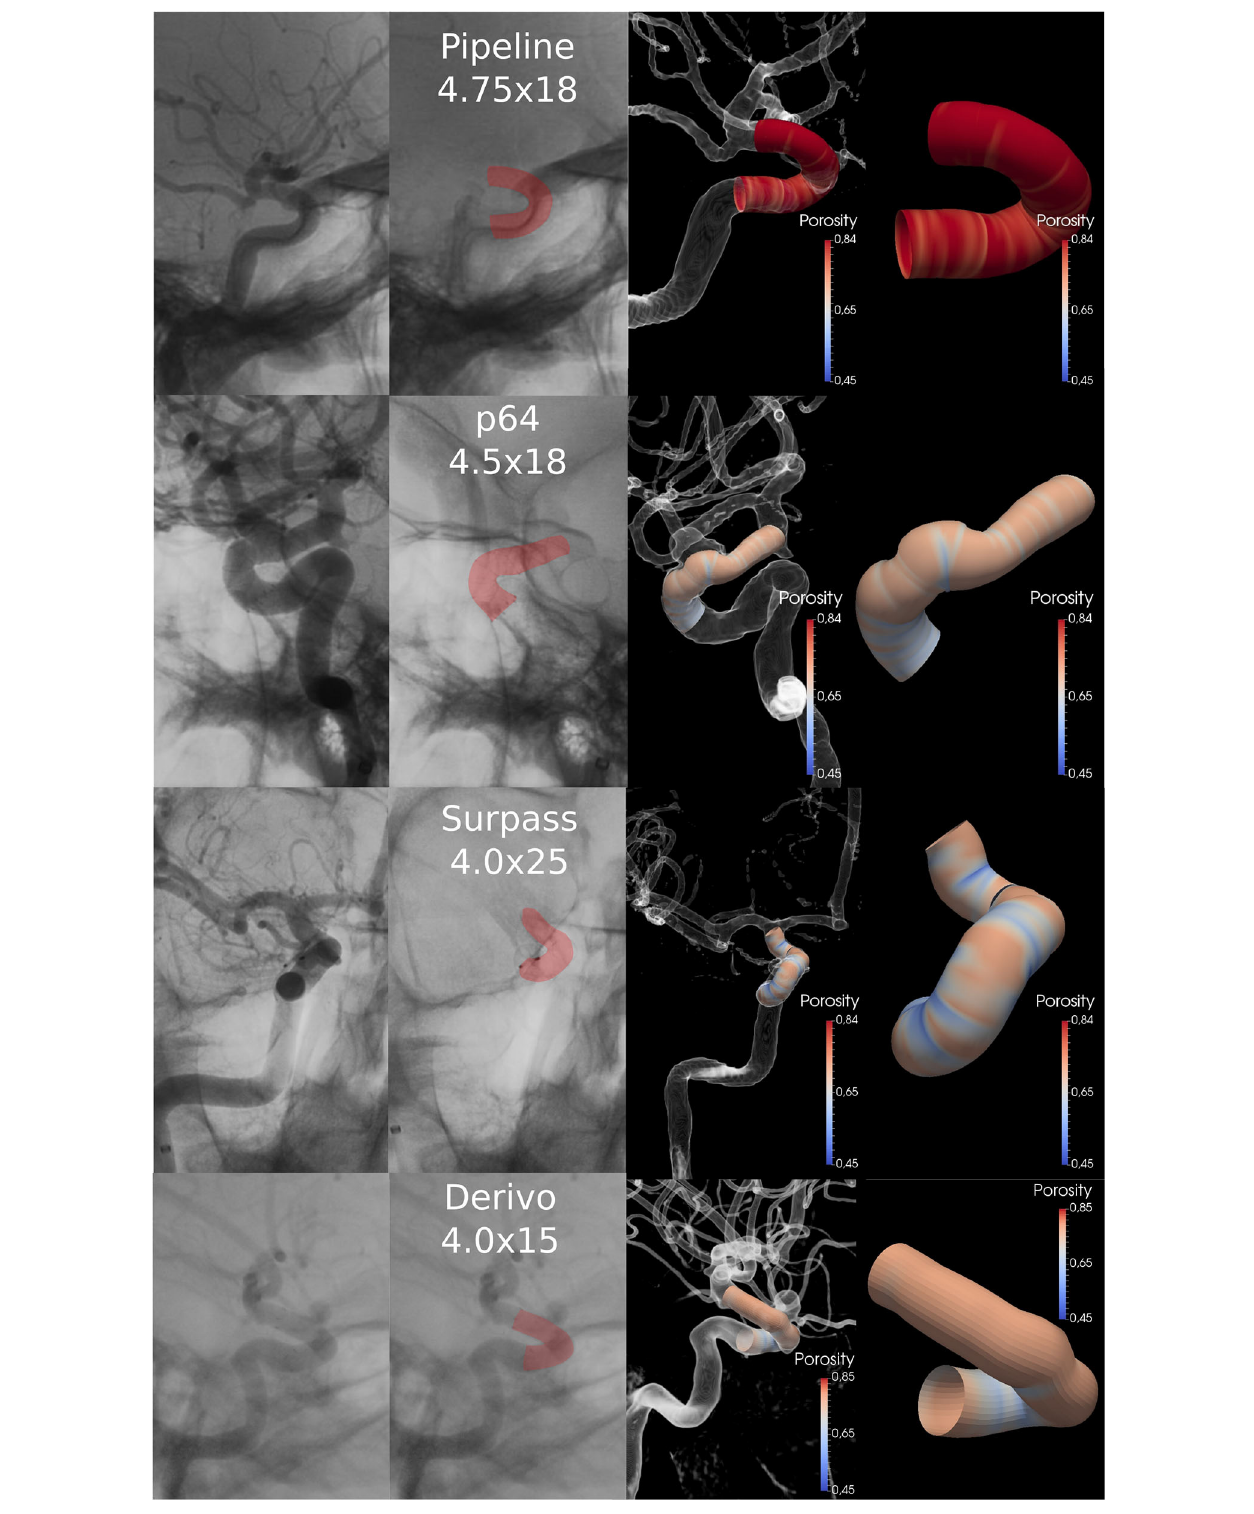
FIGURE 1 | Graphical interface of ANKYRAS, presenting the centerline extraction tools and the quantitative analysis visualization (in this case, cross-section perimeter). The interface of ANKYRAS is 100% hosted by a standard web-browser and can be accessed from any operative system.